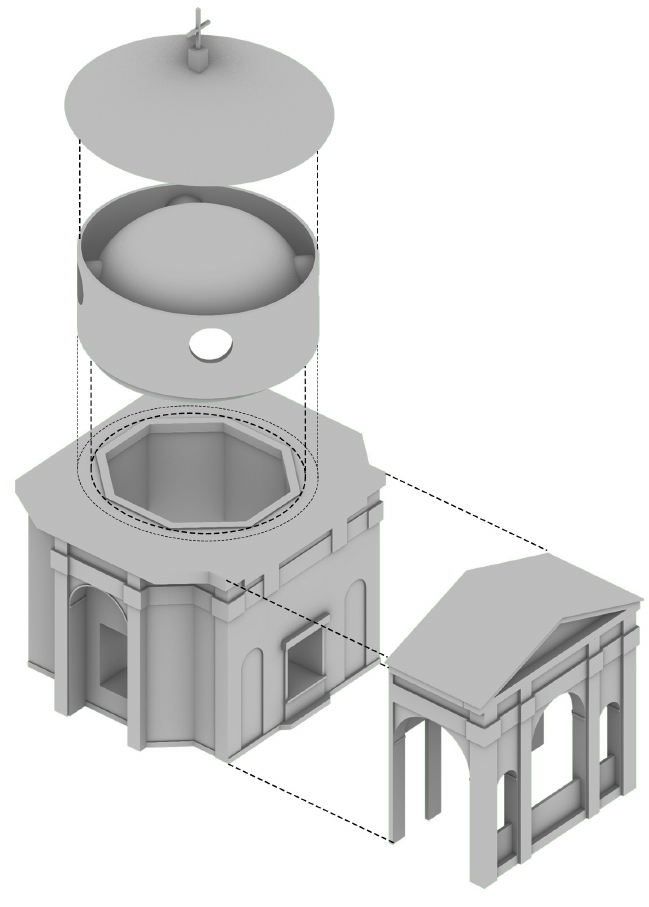
Fig. 7 Chapel VIII, axonometric